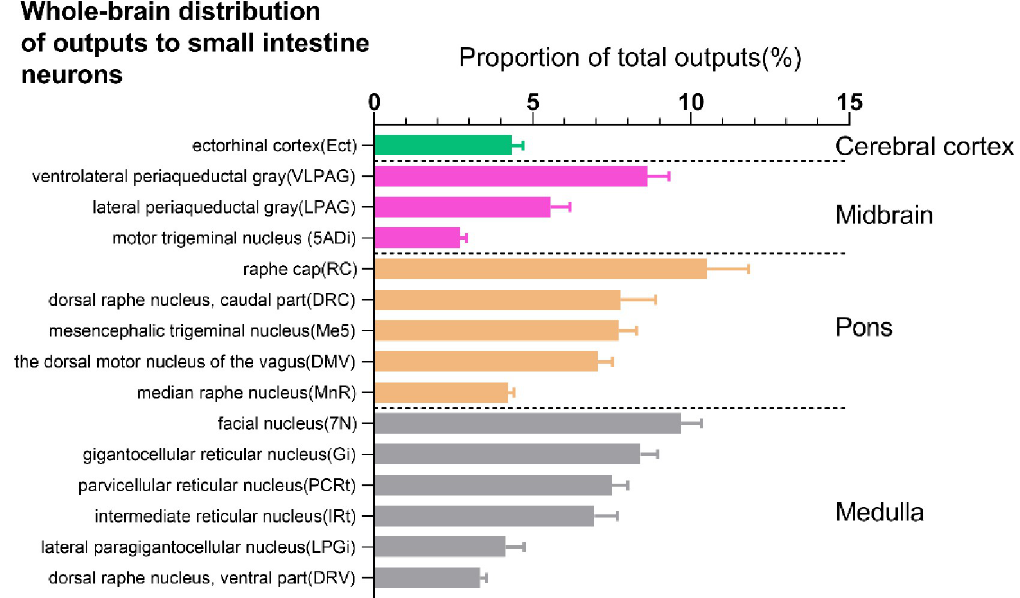
Fig 3. Statistical analysis of the whole-brain distribution of outputs to small intestine. These data are based on the ratio of the number of mRFP-expressing neurons in each nucleus to the total number of labeled neurons in each brain (n = 4 mice). Percentages report retro-labeled output neurons from 15 regions in C57/BL mice. Brain areas are grouped into four general structures: cerebral cortex, midbrain, pons, and medulla.